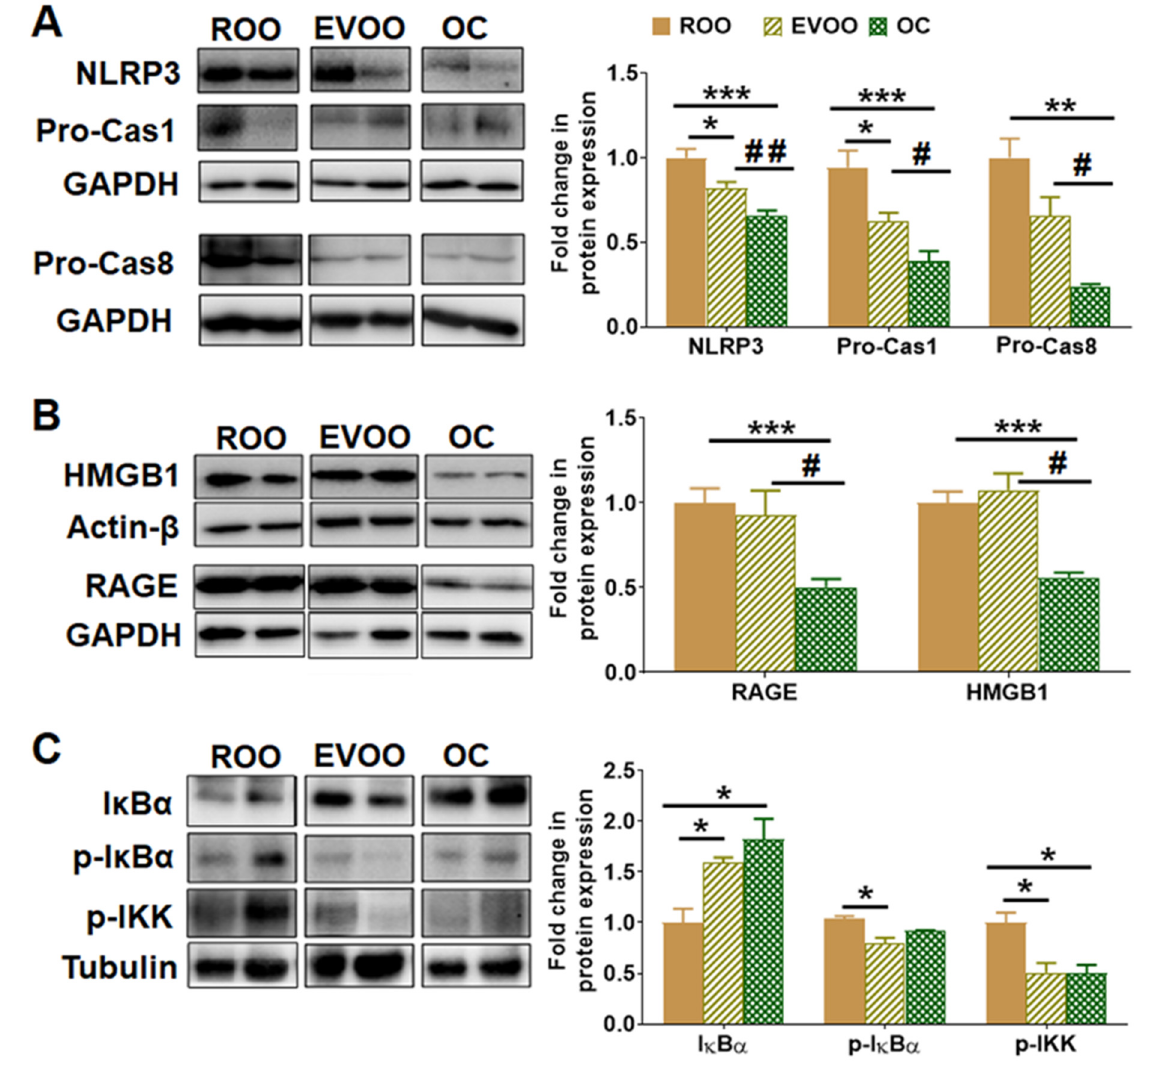
Figure 6. Effect of EVOO and OC consumption (0.5 μ g/kg) for three months on the neuroinflammation markers NLRP3, RAGE, and HMGB1, and NF ‐κ B pathway in 5xFAD mouse brains. ( A ) Representative blots and densitometry analysis of NLRP3, pro ‐ caspase 1 (Pro ‐ Cas1), and pro ‐ caspase 8 (Pro ‐ Cas8) in brain homogenates. ( B ) Representative blots and densitometry analysis of RAGE and HMGB1, and ( C ) Representative blots and densitometry analysis of I κ B α , p ‐ I κ B α , and p ‐ IKK α (n = 6–8 mice per group). Values were normalized to the ROO group (1.0). Data are presented as mean ± SEM. * p < 0.05, ** p < 0.01, *** p < 0.001 compared to ROO; and # p < 0.05, ## p < 0.01 compared to EVOO.